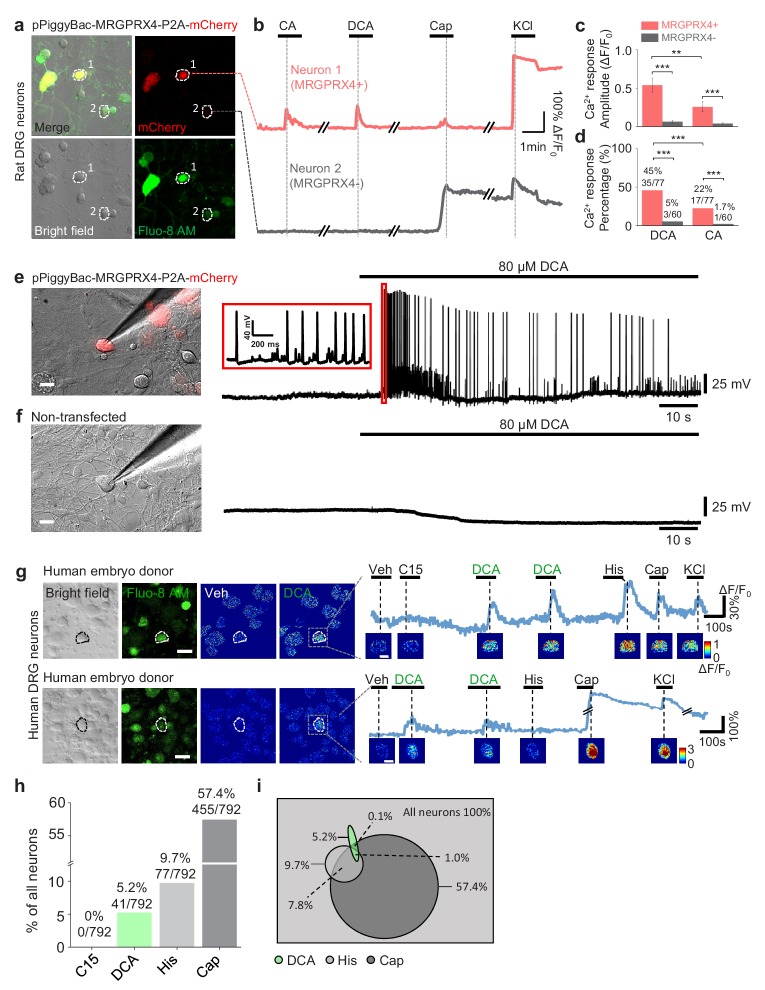
MRGPRX4 mediates bile acids induced activation of DRG neurons.(a) Top, cultured rat DRG neurons were transfected with the pPiggyBac-CAG-MRGPRX4-P2A-mCherry plasmid by electroporation. The neurons circled by dashed lines are an MRGPRX4-positive neuron (neuron one with red fluorescence) and an MRGPRX4-negative neuron (neuron 2). (b) Representative traces from the cells indicated in (a). DCA and CA: 10 μM; capsaicin (Cap): 1 μM; KCl: 75 mM. (c, d) Summary of the amplitude and percentage of Ca2+ signals in response to DCA and CA from MRGPRX4-positive and MRGPRX4 negative neurons in (a, b). Responsive neurons were defined as exceeding a threshold of 20% ΔF/F0. n = 60–77 neurons per group. All error bars represent the s.e.m.. Student’s t-test and two-proportion z-test, **p<0.01, ***p<0.001. (e, f) Representative images and electrophysiological recording of DCA induced action potentials in cultured DRG neurons transfected with MRGPRX4. Cultured rat DRG neurons were transfected with the pPiggyBac-CAG-MRGPRX4-P2A-mCherry plasmid by electroporation. Red fluorescence indicated MRGPRX4-expressing neurons. DCA induced a series of action potentials in MRGPRX4-expressing cells (e) but not in non-transfected cells (f). Scale bar, 20 μm. (g) Bile acids induced a Ca2+ response in a subset of cultured human embryo DRG neurons. (left) Representative bright-field images and Fluo-8 fluorescence images of DRG neuron cultures from one embryo donor. The pseudo-color images show the DCA-induced calcium responses of all imaged neurons. (right) Representative traces of individual DCA-responsive DRG neurons (circled by the dash line in [left]). Pseudo-color images of chemical-induced signals are shown under each trace. C15 (compound 15), CA, DCA, and His (histamine): 100 μM each; KCl: 75 mM. Veh, vehicle. Scale bar, 50 μm. (h) Percentage of human embryo DRG neurons that were responsive to the indicated tested compounds measured as in (g). (i) Venn diagram of the cultured human embryo DRG neurons that were activated by the indicated tested compounds. Green represents DCA responded neurons; Heavy gray represents capsaicin responded neurons; light gray represents histamine responded neurons.